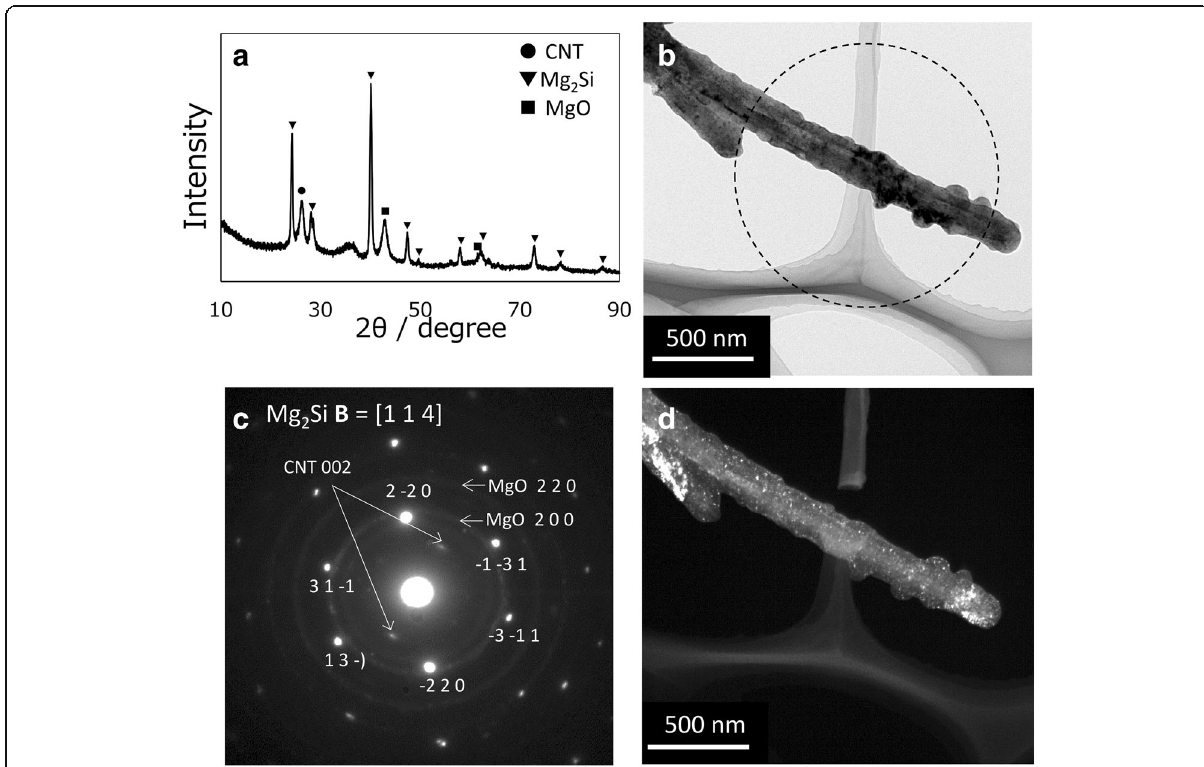
Fig. 4 XRD profile and TEM images of the nanofiber after the reaction of Si with magnesium. a XRD profile of the nanofiber. b Bright field image. d The corresponding dark-field image taken with the MgO 200 diffraction spots. The area surrounded by dashed line in b indicates the observed area of SAED pattern. c SAED pattern of the